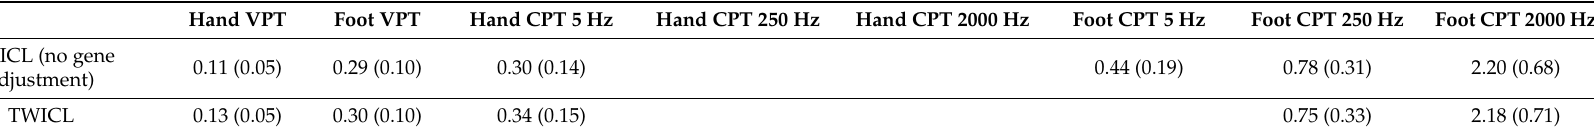
Table 4. Linear regression models of the association of neurological examination outcomes with TWICL exposure and gene polymorphisms among the lead workers. Only regression coe ffi cients (standard error) that were significant ( p < 0.05) are shown